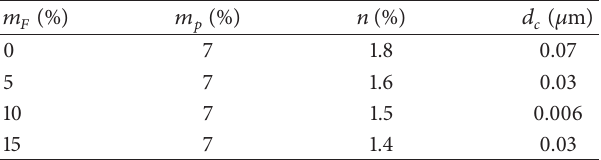
Table 3: Effect of introducing calcareous fillers on the porosity parameters of MPC.